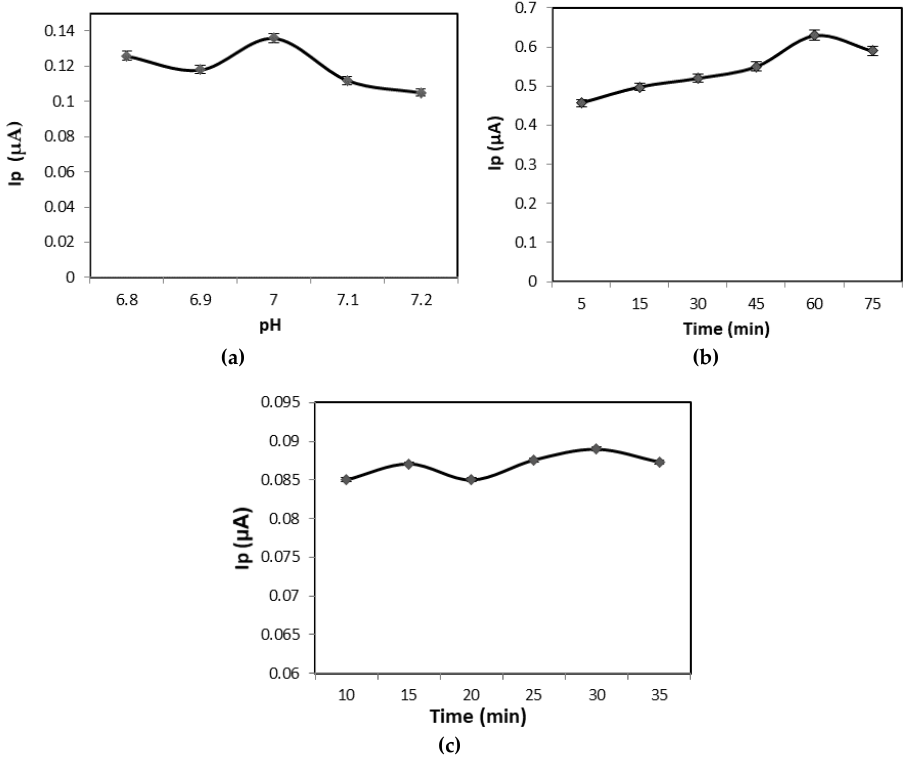
Figure 10. Differential pulse voltammograms (DPV) of DNA biosensor during optimization parameters ( a ) pH of buffer solution; ( b ) immobilization time of DNA probe, and ( c ) hybridization time of DNA target in phosphate buffer (0.1 M, pH 7) consisting MB (35 µM) at potential −0.2 V to 0.8 V.